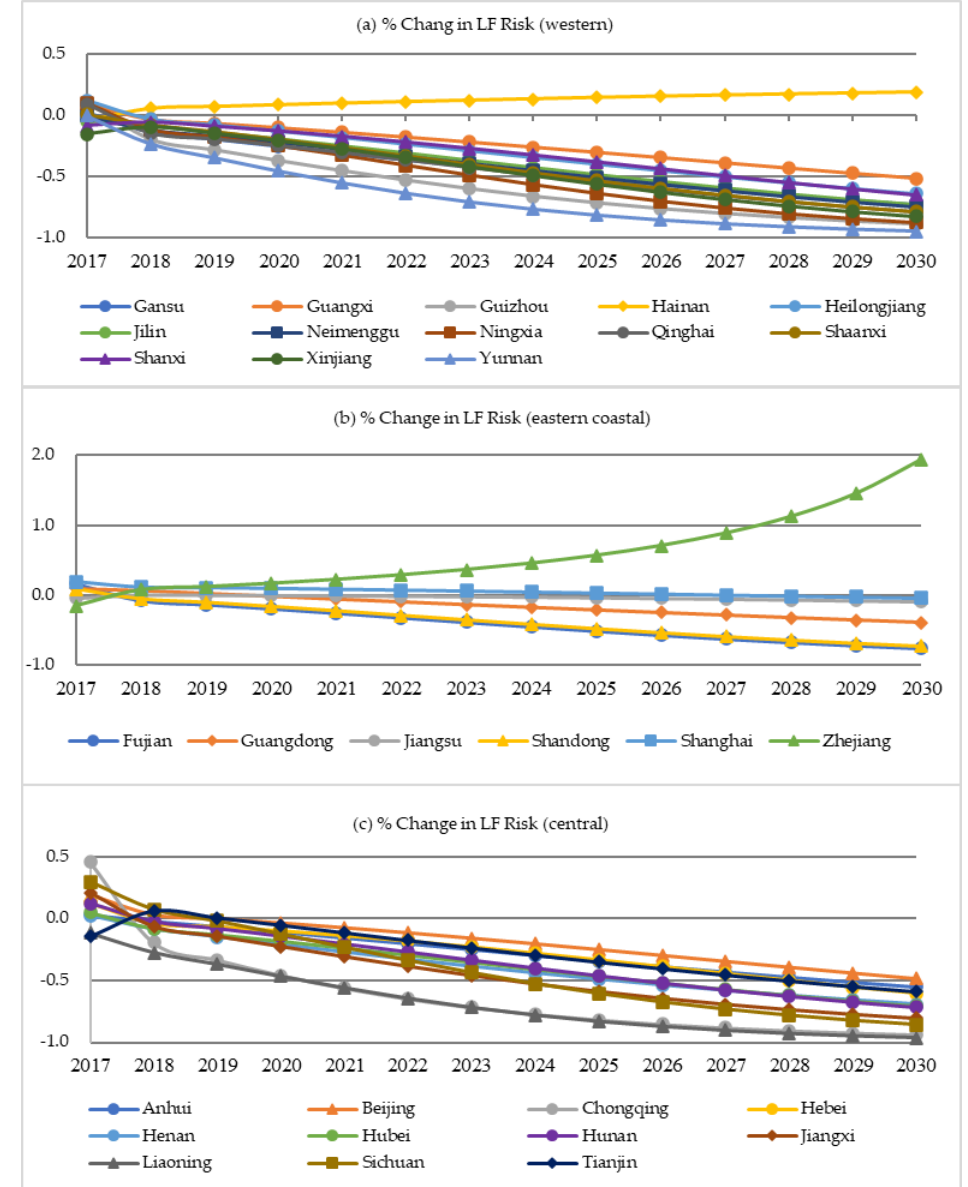
Figure 11. Annual change in land finance risks from 2017 to 2030.